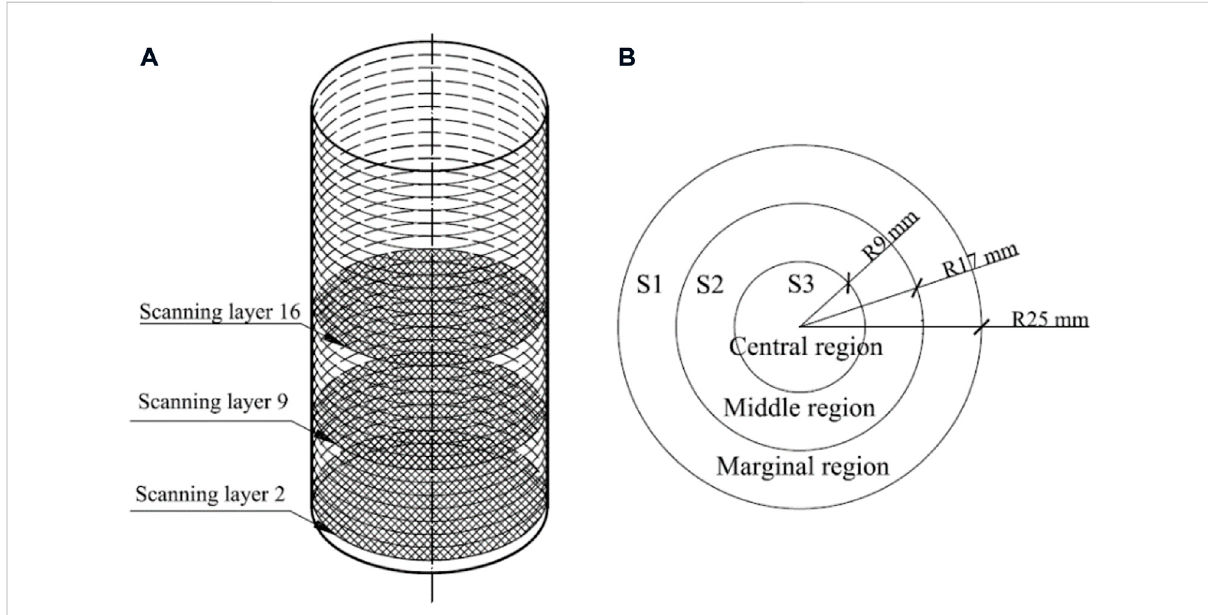
FIGURE 5 CT scanning layers. (A) scanning position; (B) regional